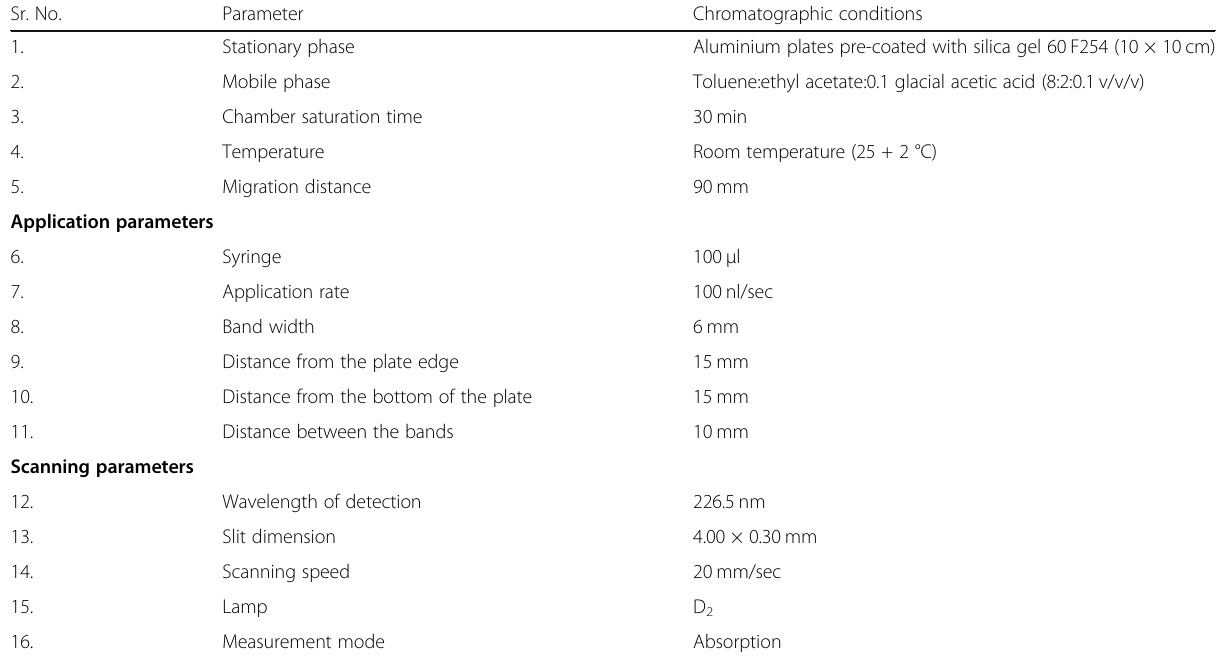
Table 2 Chromatographic conditions used for the method Sr.